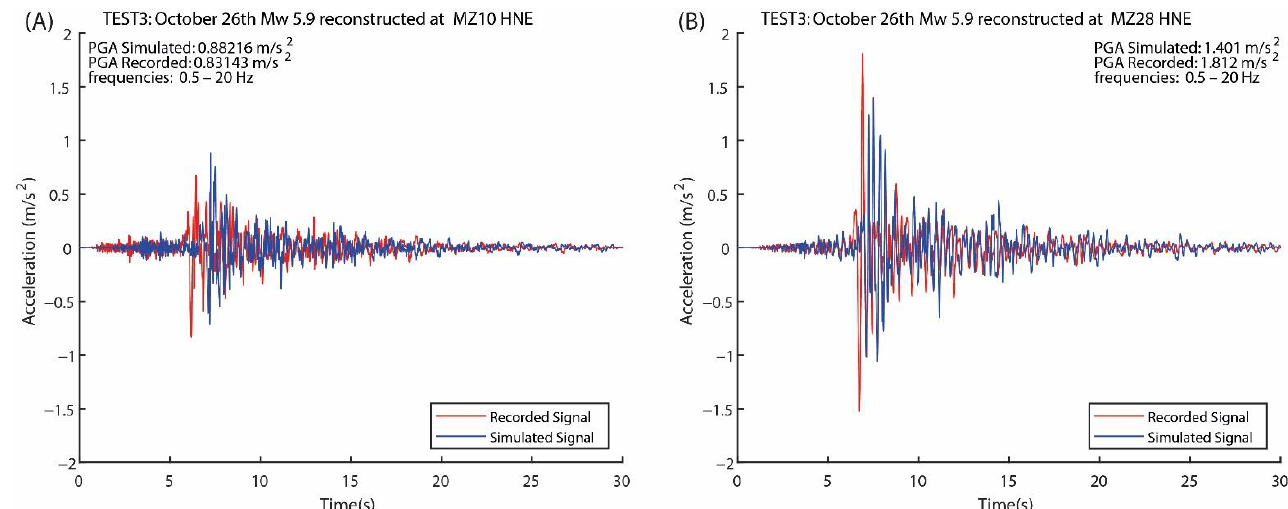
Figure 8. Comparison between recorded and simulated seismograms (EW component of acceleration) at MZ10 ( A ) and MZ28 ( B ) for Test 3. Red (blue) line represents the recorded (simulated) signal between 0.5 – 20 Hz.